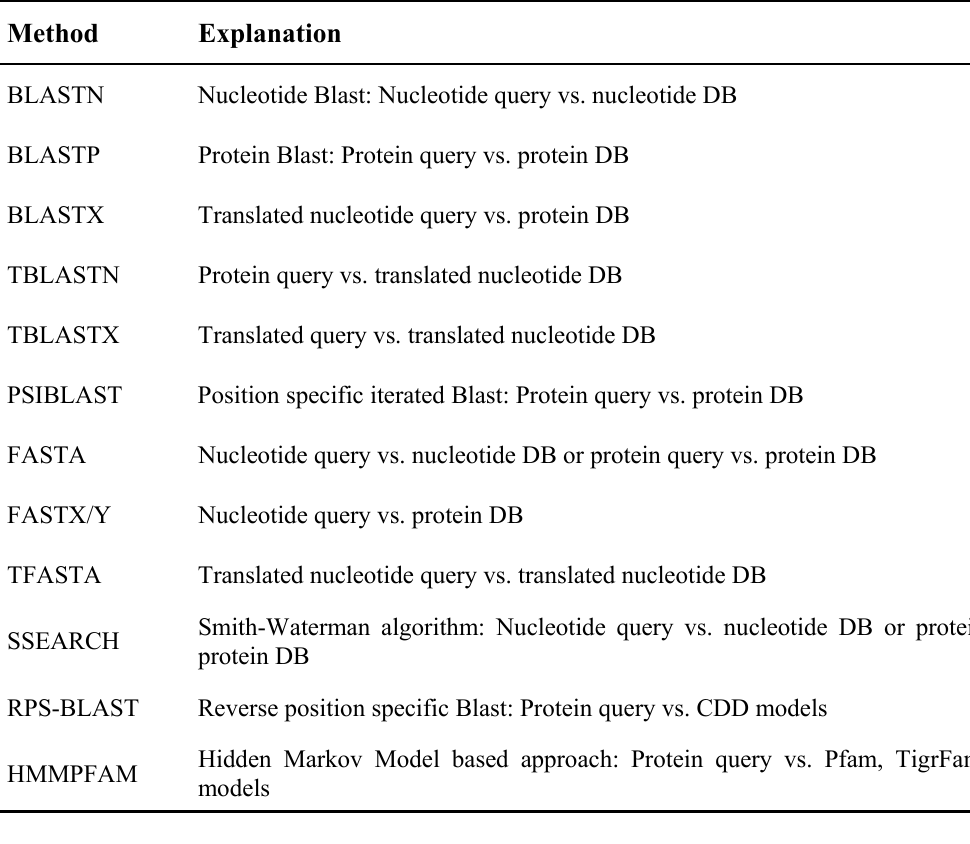
Table 2: Supported sequence analysis methods Method